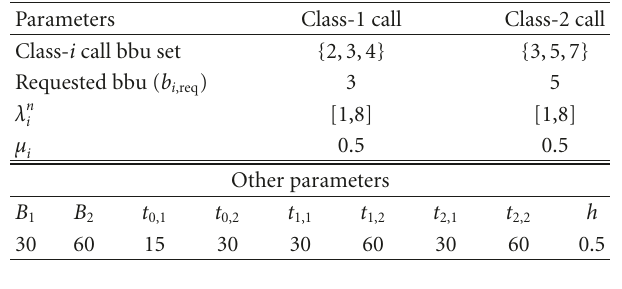
Table 1: Simulation parameters.